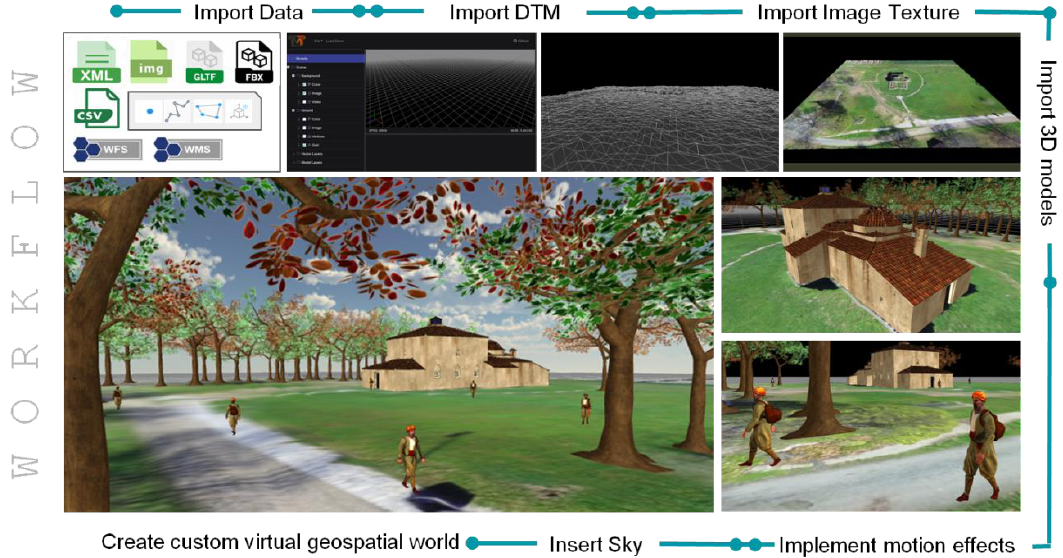
Figure 8. The workflow of the creation of a custom virtual geospatial world.